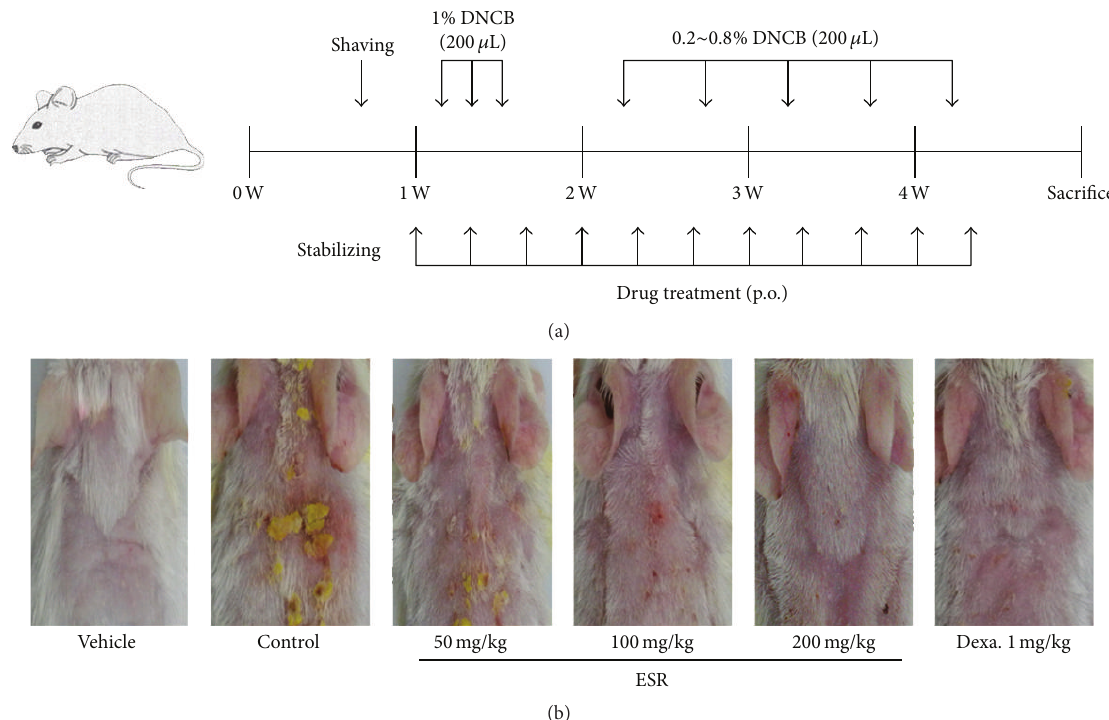
Figure 1: Effects of ESR on the development of DNCB-induced AD mouse skin lesions in BALB/c mice. (a) Experimental schedule for the induction of dermatitis. (b) Effects of ESR on clinical features of DNCB-induced AD skin lesions. Vehicle, negative control; control, DNCB + vehicle; ESR, DNCB + ESR treated group (50, 100, and 200 mg/kg); Dexa., DNCB + 1mg/kg dexamethasone treated